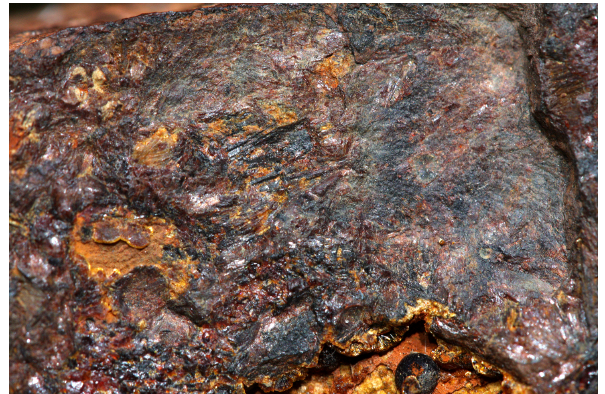
Figure 3. Dark red crystalline aggregates of beraunite associated with brown to yellow cacoxenite. Mineralogical Collection of the TU Bergakademie Freiberg, inv. no. 21519 (original beraunite spec- imen; sample FR). FOV 15mm. Photo A. Massanek.